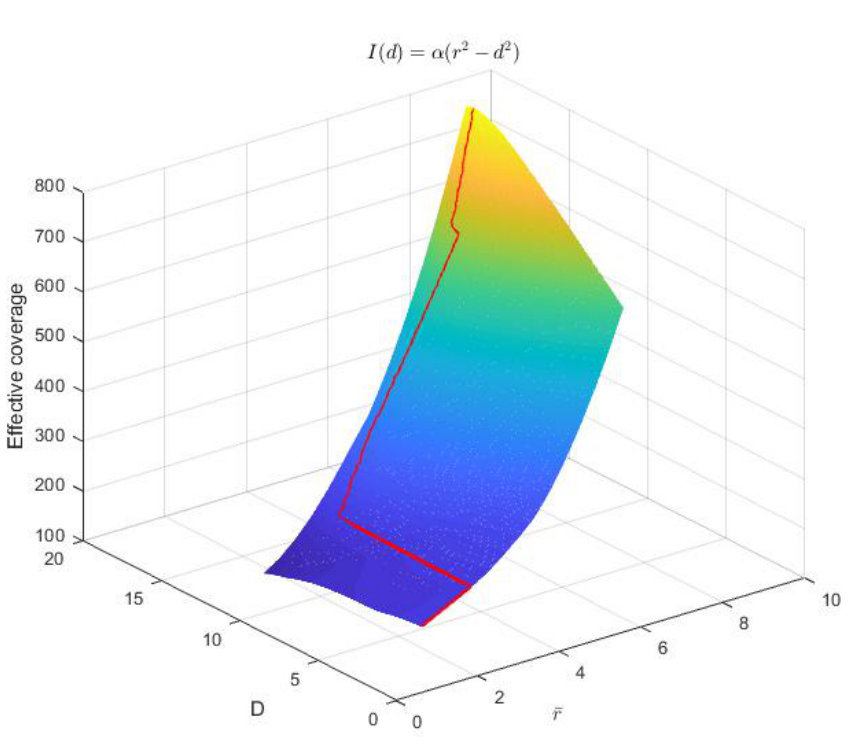
Figure 4. Three-dimensional mesh of team’s effective coverage vs. separation D and ¯ r . Nodes are equipped with concave models. r = 10. α = 1. The red curve illustrates the maximum effective coverage at every ¯ r value.